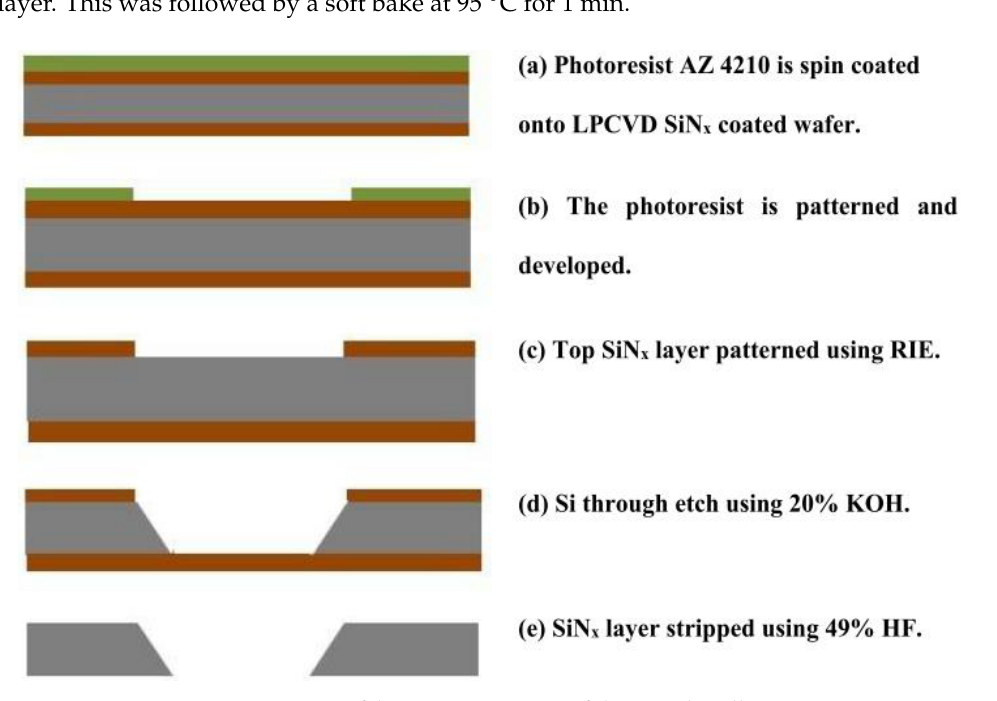
Figure A1. Micro fabrication processes of the sample collector.